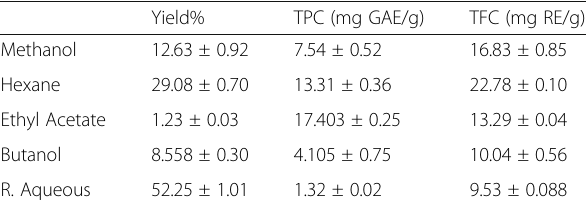
Table 1 Total yield, total phenolic content and total flavonoid content of methanol extract and its different fractions